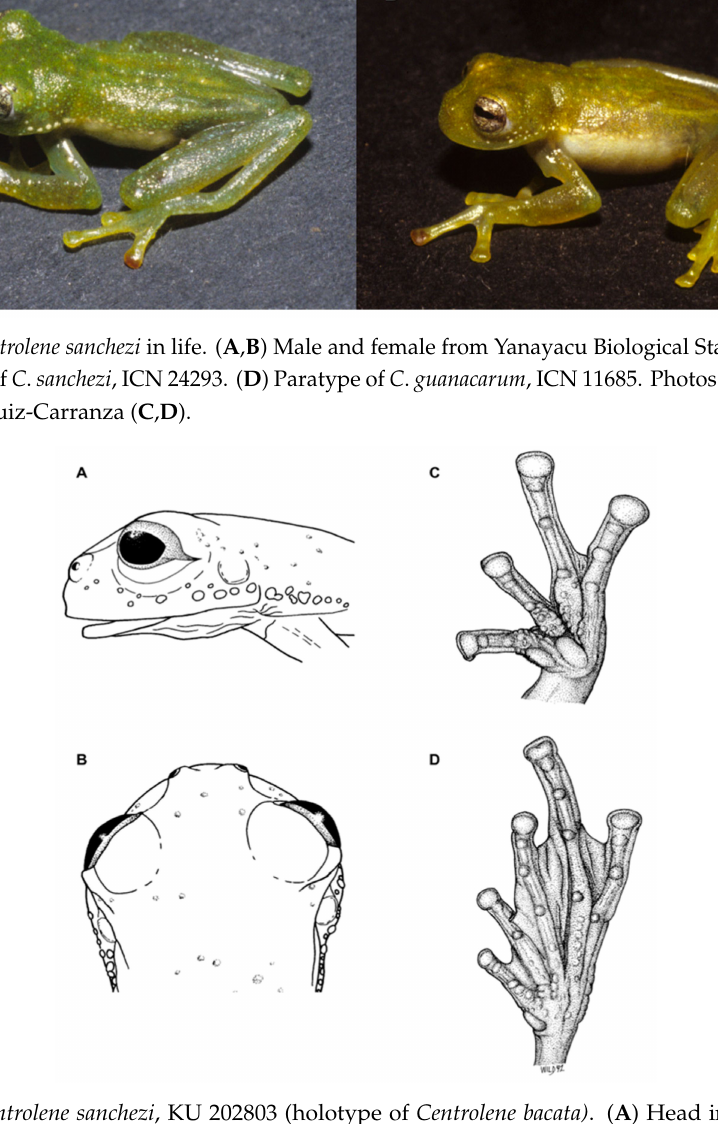
Figure 58. Centrolene sanchezi , KU 202803 (holotype of Centrolene bacata) . ( A ) Head in lateral view. ( B ) Head in dorsal view. ( C ) Hand in ventral view. ( D ) Foot in ventral view. Drawings not to scale. Modified from Wild